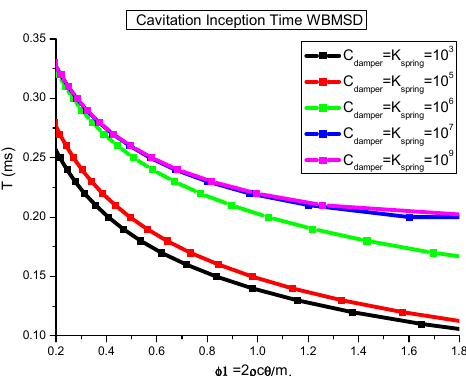
Figure 5. For different values of C damp and k, the dependence of the cavitation time on the non-dimensional parameter φ 1.